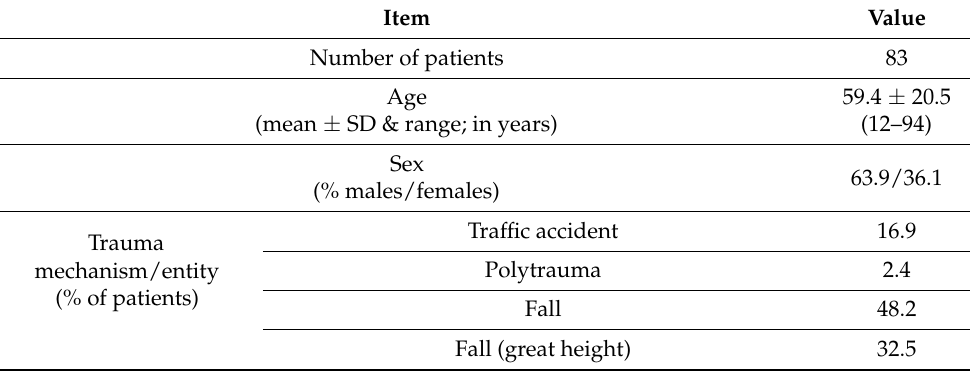
Table 2. Patient